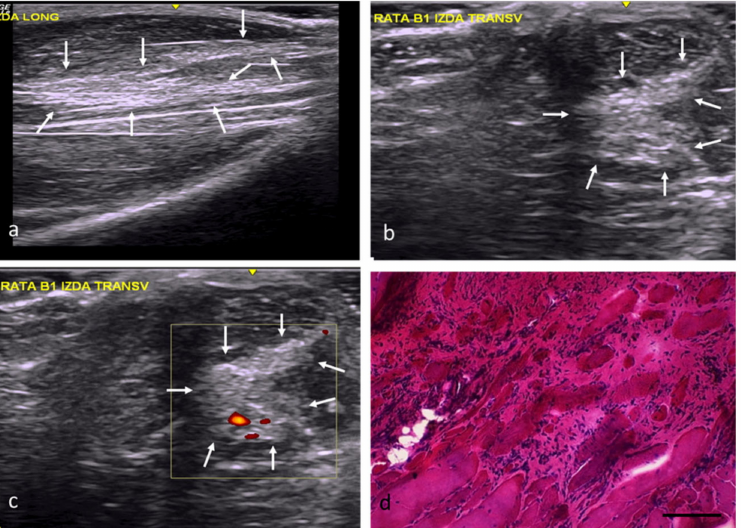
Figure 3. FC group. ( a ) Longitudinal axis, with images of a hyperechoic area compared with the normal muscle tissue and a distorted echostructure, demarcated by white arrows. ( b ) Transverse axis, with images of a well-defined injury with angular margins and increased echogenicity. ( c ) Transverse section assessed by power Doppler imaging, with images of a slight, predominantly peripheral, increase in vascularization. ( d ) Transverse section representative of the muscle histology. H-E. Size scale: 100 µ